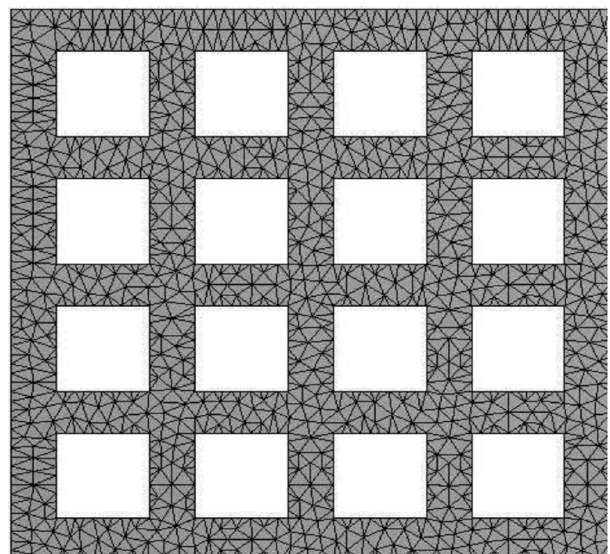
Fig. 3. FE model of the Cubic (76) porous structure.